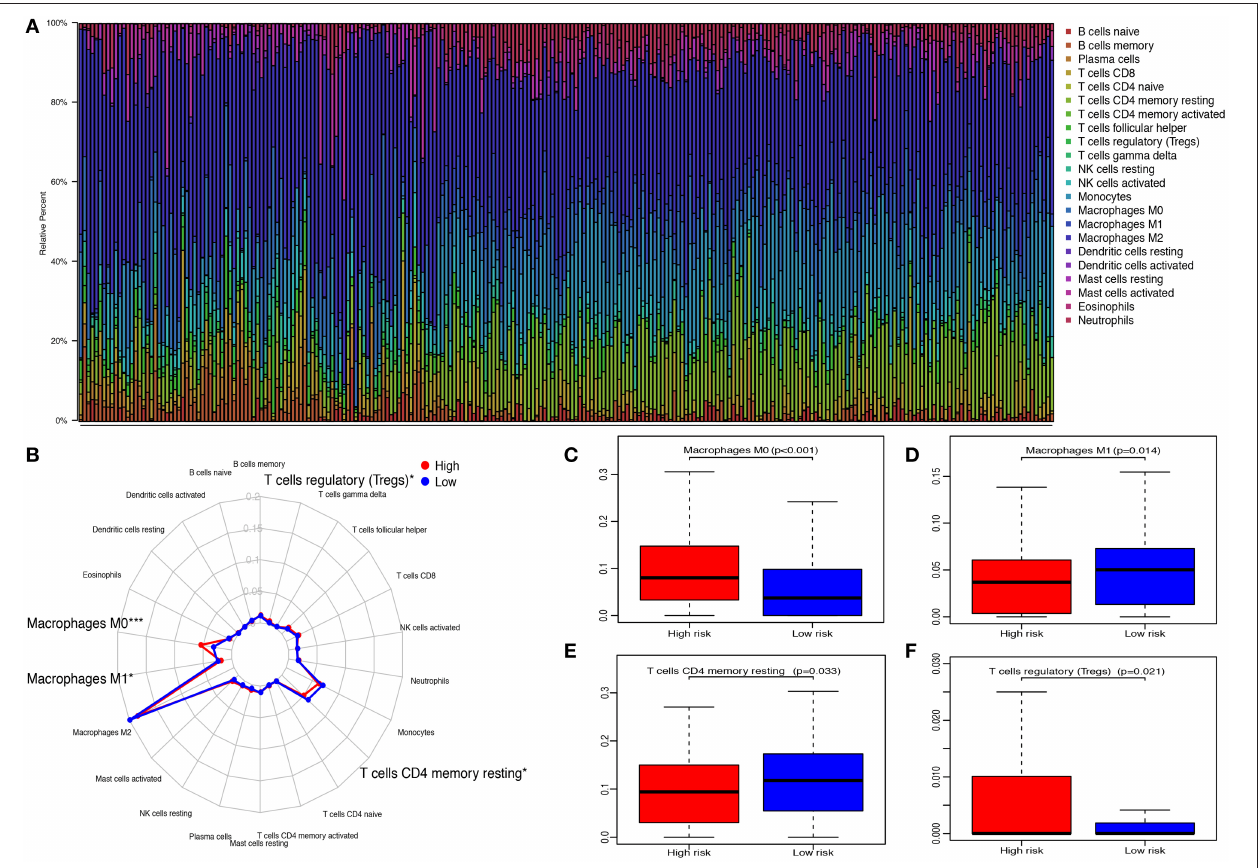
FIGURE 7 | Relationship between immune-related gene pairs (IRGPs) and tumor-infiltrating immune cells (TIICs). (A) The proportions of 22 TIICs in 248 samples were quantified by CIBERSORT. (B) The difference of 22 TIICs between high- and low-risk groups. (C) The difference of macrophages M0. (D) The difference of macrophages M1. (E) The difference of resting CD4 memory T cells. (F) The difference of regulatory T cells (Tregs) between high- and low-risk groups. * p < 0.05, *** p <